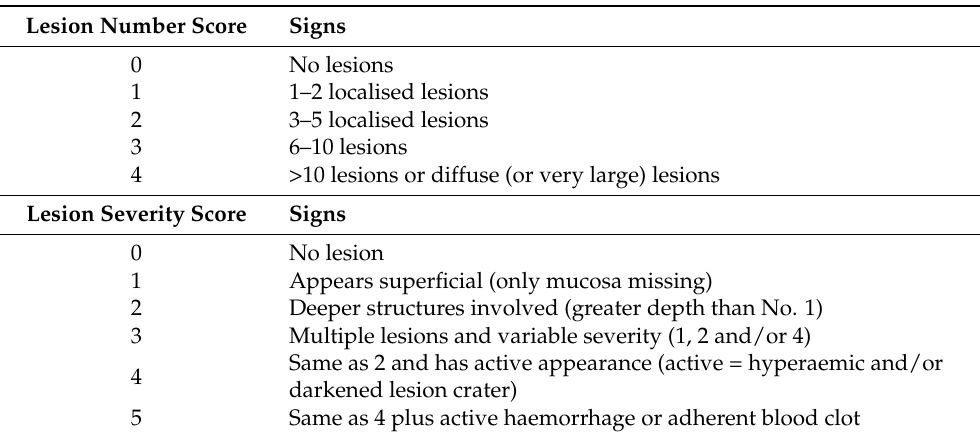
Table 3. Ulcer Number and Severity Scale